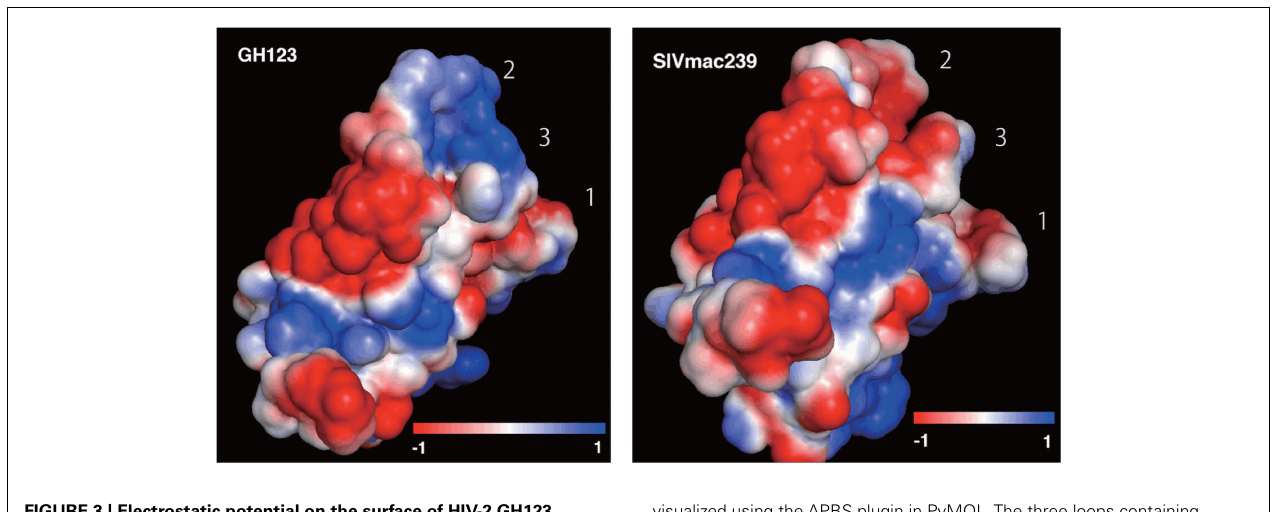
FIGURE 3 | Electrostatic potential on the surface of HIV-2 GH123 (GH123) and SIVmac239 capsid protein N-terminal domains. Structures are positioned as in Figure 2 with the loops directed toward the upper right of the image. Electrostatic potential was calculated and